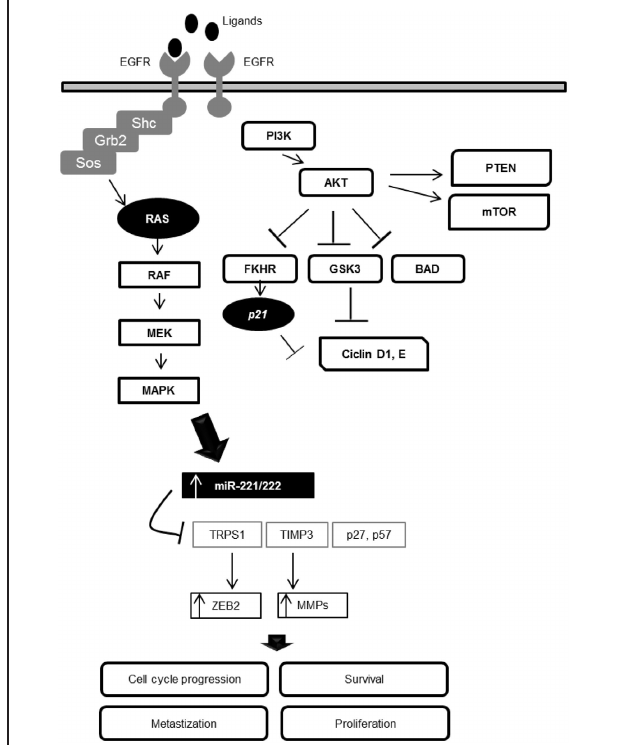
FIGURE 2 | Interaction loop between the EGFR signaling pathway and miR-221/222 expression in the modulation of cellular